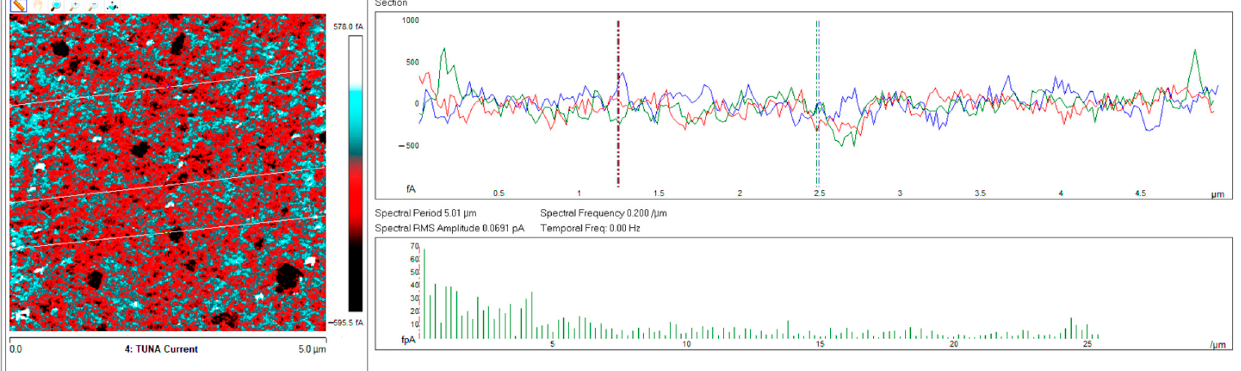
Figure 17. From left to right, TUNA Current picture and current variation profile of the sample TCTBD+0.5%MWCNT.